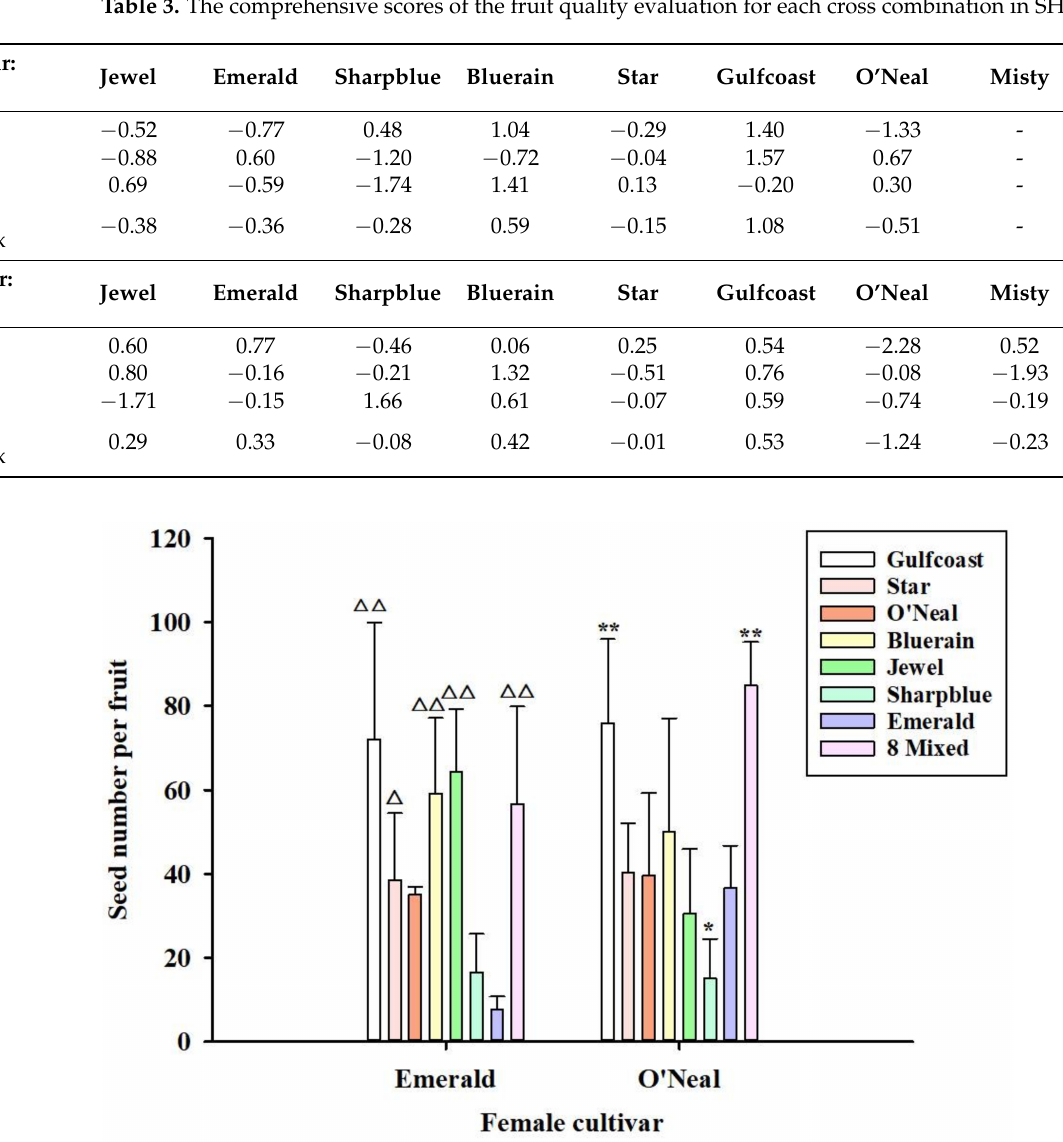
Table 3. The comprehensive scores of the fruit quality evaluation for each cross combination in SHB.